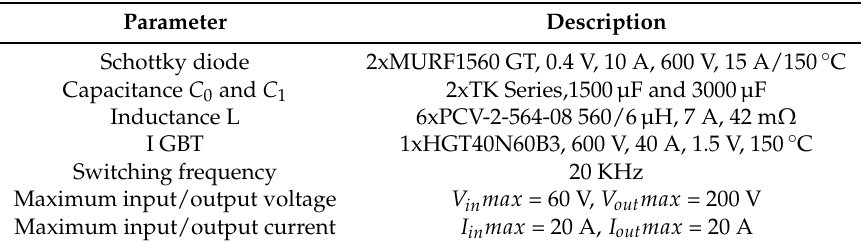
Table 2. Technical specifications of the DC–DC boost